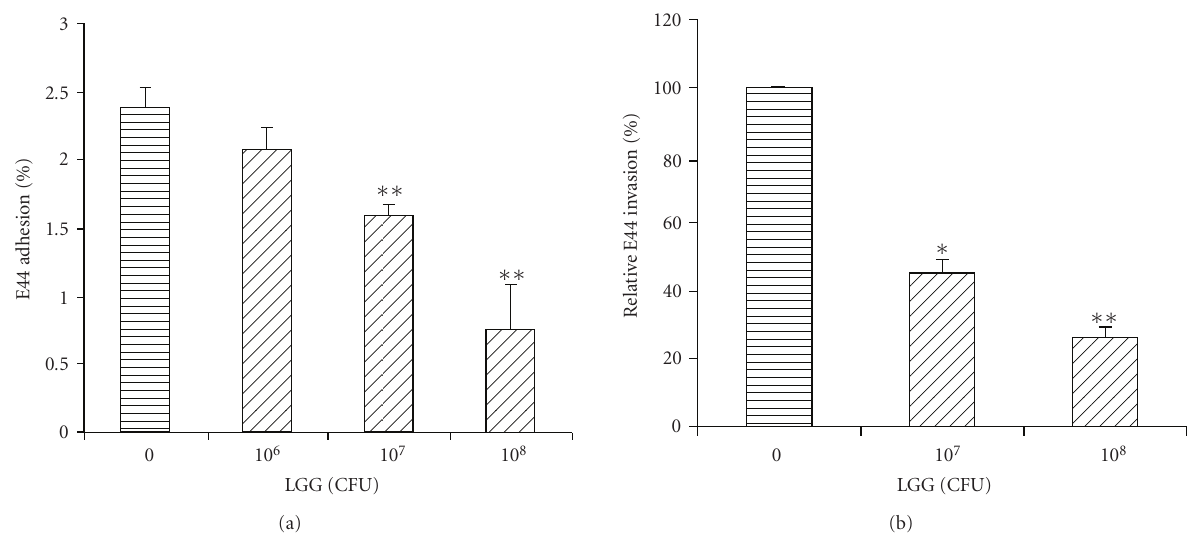
Figure 1: E ff ects of LGG on E. coli K1 adhesion to and invasion of Caco-2. Epithelial cells were incubated with various doses of L. rhamnosus for 3 hours before adding bacteria. Adhesion and invasion assays were carried out as described above. All values represent the means of triplicate determinations. The results were expressed as adhesion (Figure 1(a)) or invasion activities (Figure 1(b)) compared to that of the control without LGG. Error bars indicate standard deviations. ∗ P < . 05; ∗∗ P < .